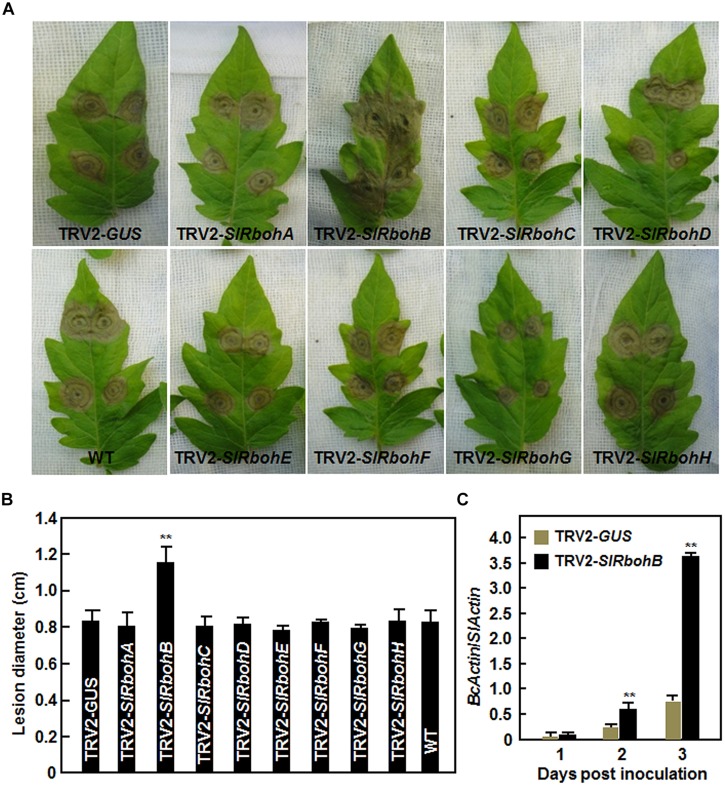
Silencing of SlRbohB led to reduced resistance to B. cinerea. (A) Disease symptom and (B) lesion size. Two-week-old plants were infiltrated with agrobacteria harboring TRV2-SlRbohA–H or TRV2-GUS and leaves were detached for disease assays at 4 weeks after VIGS infiltration. Inoculation was done by dropping spore suspension (1 × 105 spores/mL) on detached leaves and lesion sizes were measured at 4 days after inoculation. A minimum of 20 leaves were included in each experiment. (C)
In planta growth of B. cinerea in inoculated leaves. Fungal growth was assumed by analyzing the transcript level of BcActin gene by qRT-PCR using SlActin gene as an internal control and shown as the ratios of BcActin/SlActin. Data presented in (B,C) are the mean ± SD from three independent experiments and ** above the columns indicate significant differences at p < 0.05 level.